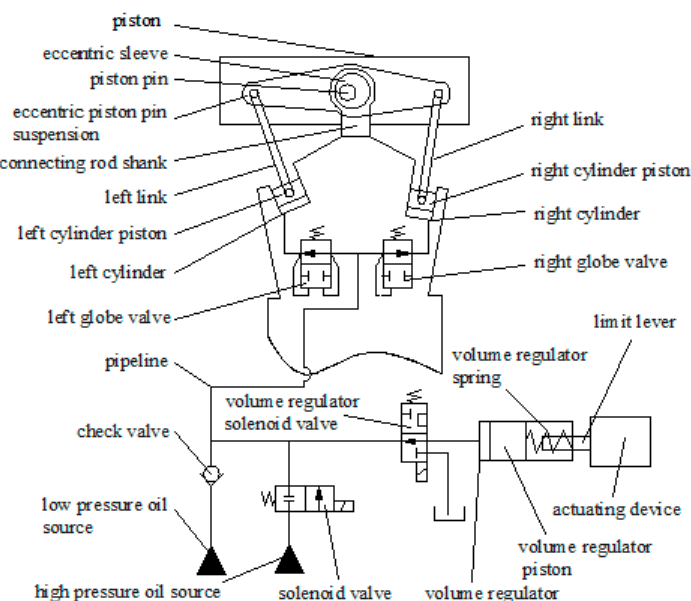
Figure 2. Schematic diagram of the hydraulic continuous variable compression ratio (VCR) system.